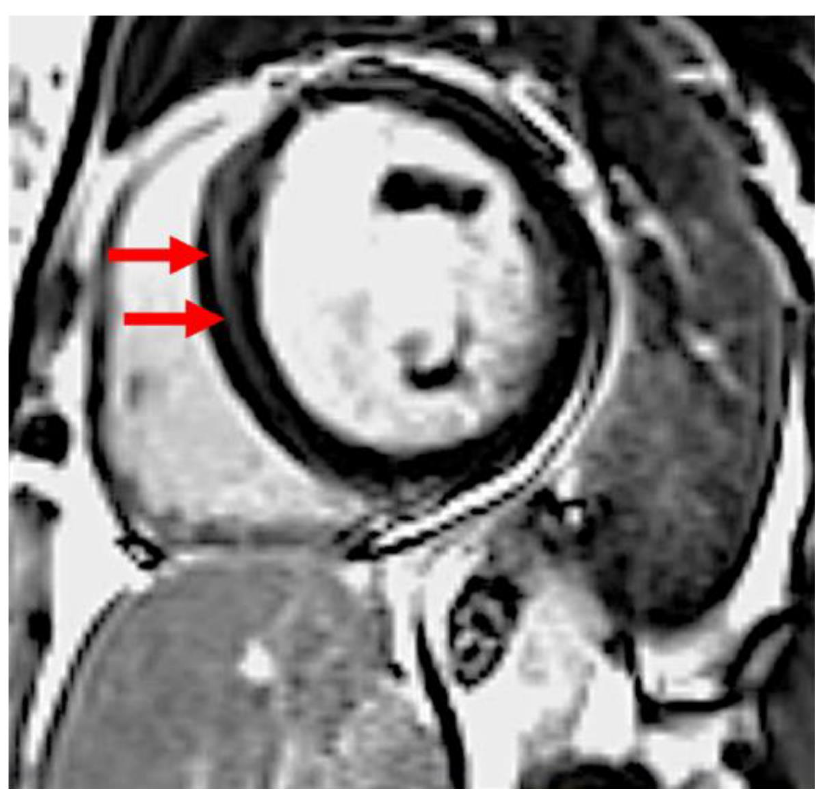
Figure 1. Late gadolinium enhancement in basal antero-septal wall in a patient with peripartum cardiomyopathy. Arrows indicate abnormal signal in the septum.